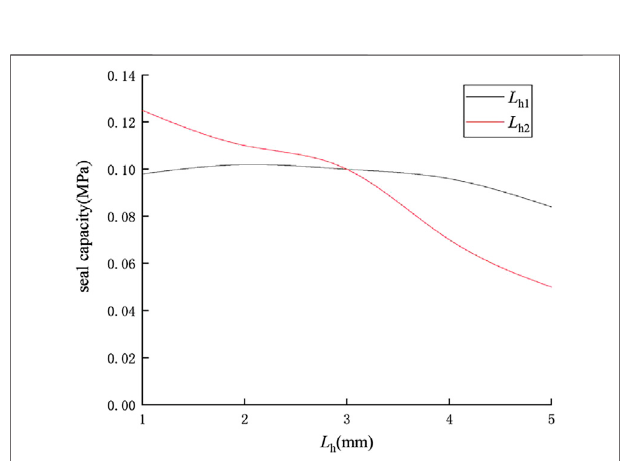
FIGURE 4 | Relationship between seal capacity and Lh.